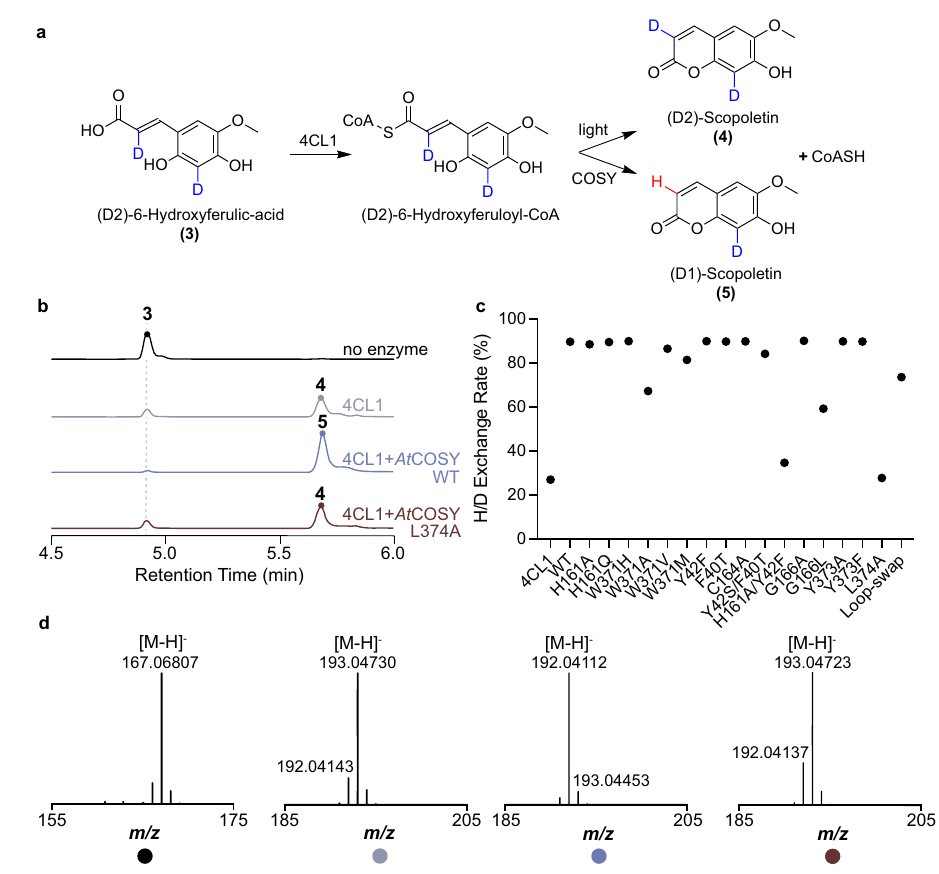
Fig.3| InvitrocoupledenzymeassaythatexaminestheH/DexchangeatC2of the(D2) − 6OHFA substrate. a Reactionschematic for the conversion of 3 , (D2) − 6- Hydroxyferulic-acid into 4 , (D2)-Scopoletin by light and 5 , (D1)-Scopoletin by COSY. b Combined LC-MS extracted ion chromatograms (XICs) of 167.06804 m / z ; 3 ,193.04747 m / z ; 4 and192.04114 m / z ; 5 .Thecoloredcirclesrepresenttherelevant substrate or product peaks in each XIC trace corresponding to the compound number in a . c H/D exchange rate of assays conducted with no At COSY, wild-type